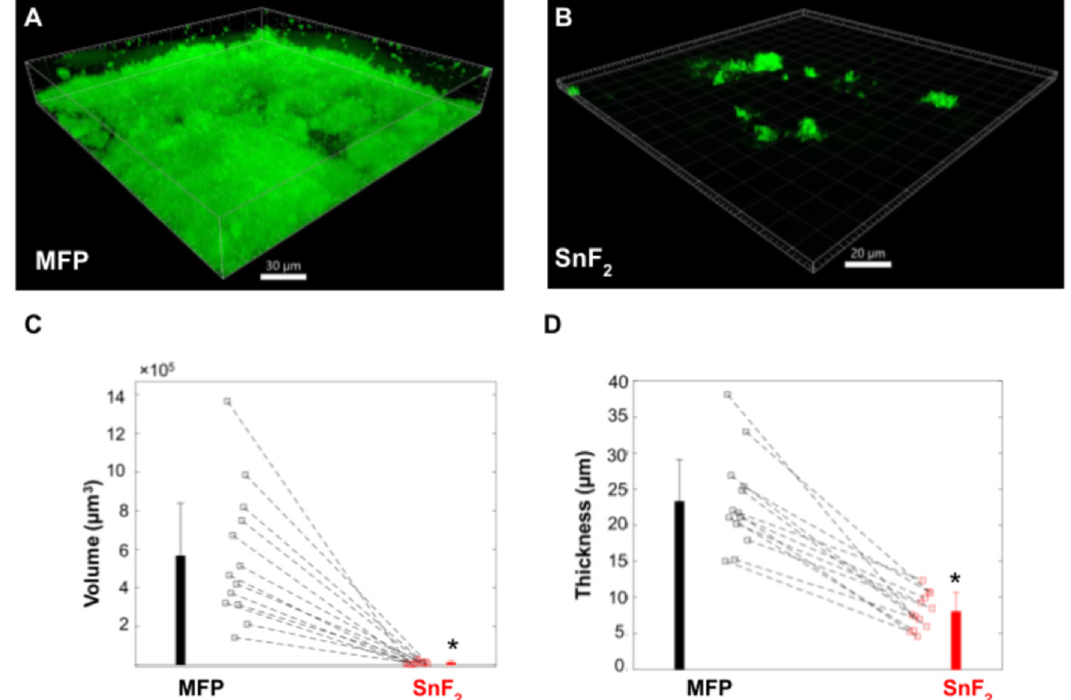
Figure 3. Confocal imaging and quantification of in situ biofilms: ( A , B ) 3D volume views of 2-day in situ biofilms formed with sodium mnofluorophosphate (MFP) and SnF 2 -containing toothpaste use for 14 days. ( C , D ) Plots of biofilm volume and thickness formed with MFP and Colgate Total SnF 2 use. Three to four data points were collected for each panelist for each condition. The squares/points represent average value for each panelist per condition and bars represent average value of the data set per condition. The error bars represent standard deviation. The average volume and thickness values are significantly lower in the SnF 2 group compared to that of MFP (* p < 0.00001, paired Student t -test).